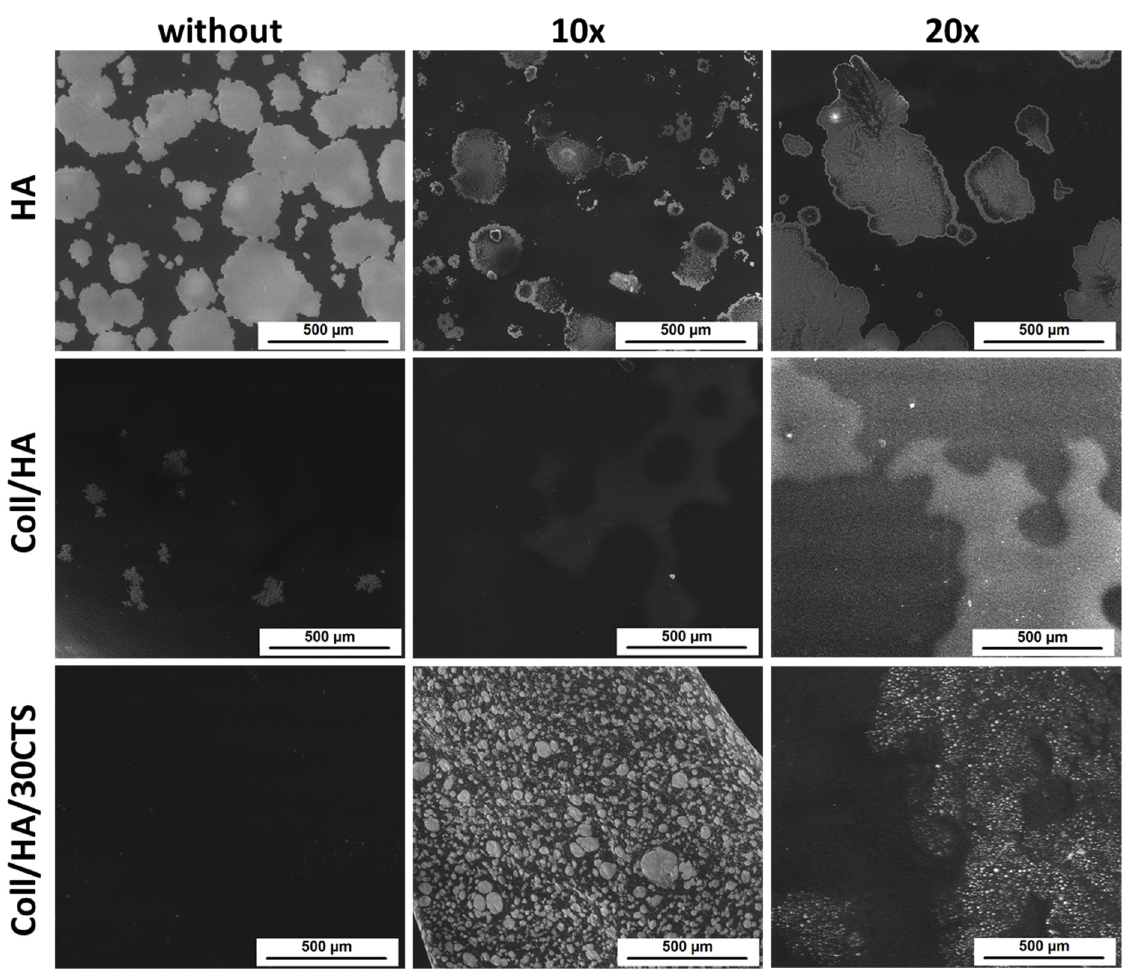
Figure 4. The SEM images of HA, Coll/HA, and Coll/HA/30CTS films before and after treatment of laser radiation (with resolution 500 µm).